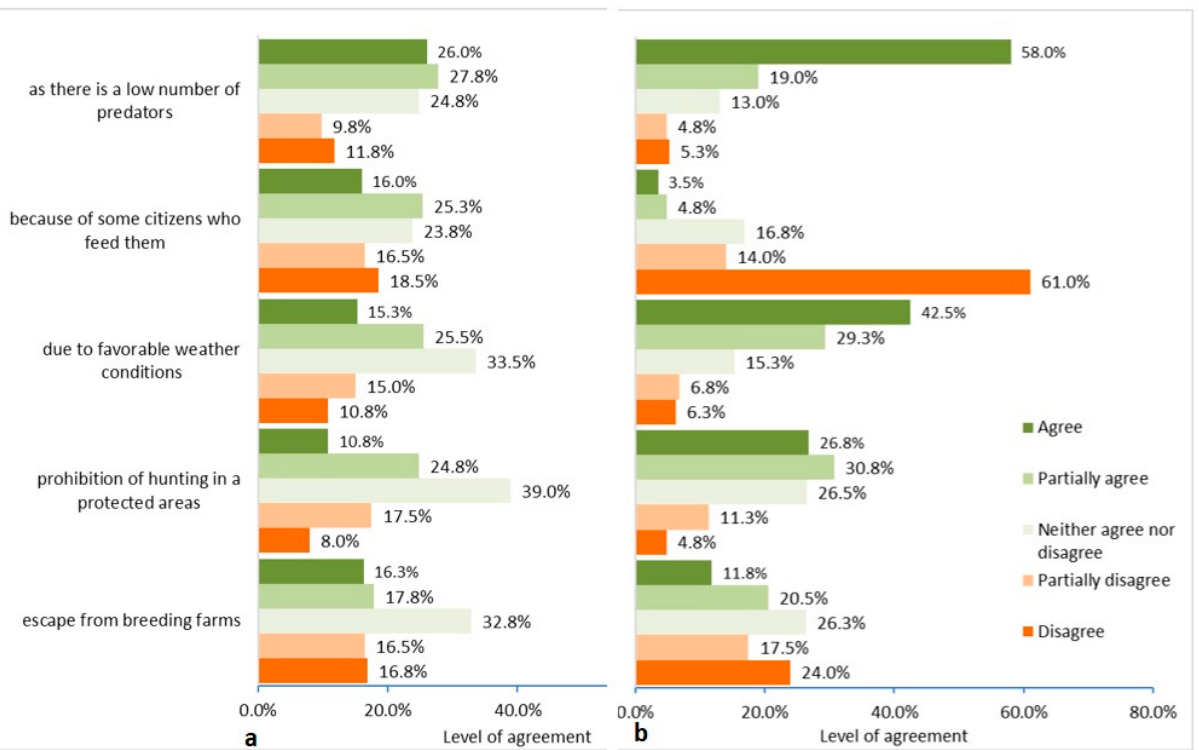
Figure 4. ( a , b ) The reasons for the magnification of the problem of invasion according to the citizens of the urban area ( a ) and the rural area ( b ).